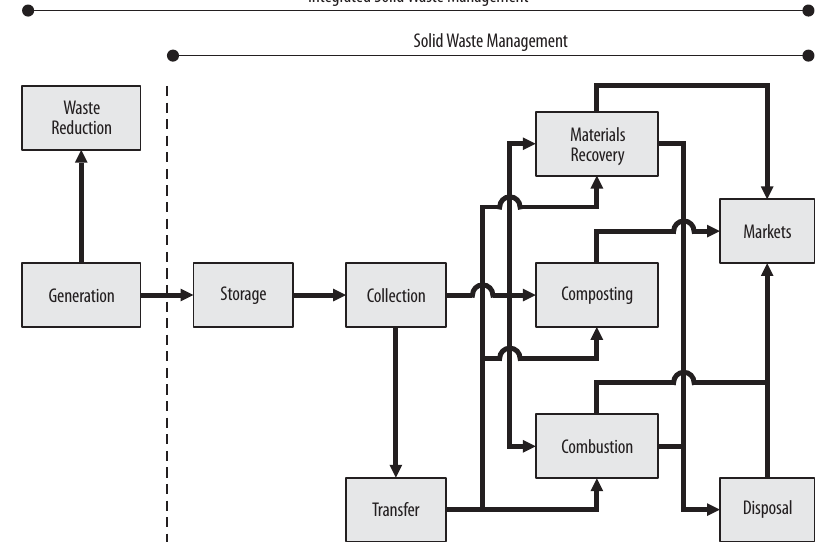
Figure 4. Solid waste management model proposed by UNEP (UNEP, 2005)